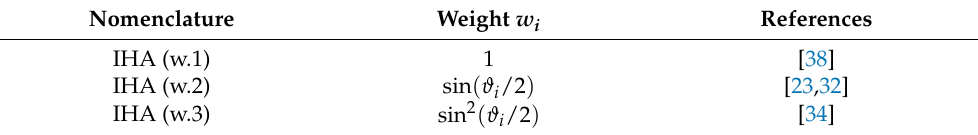
Table 2. Helical axis weighting and corresponding nomenclature used in the